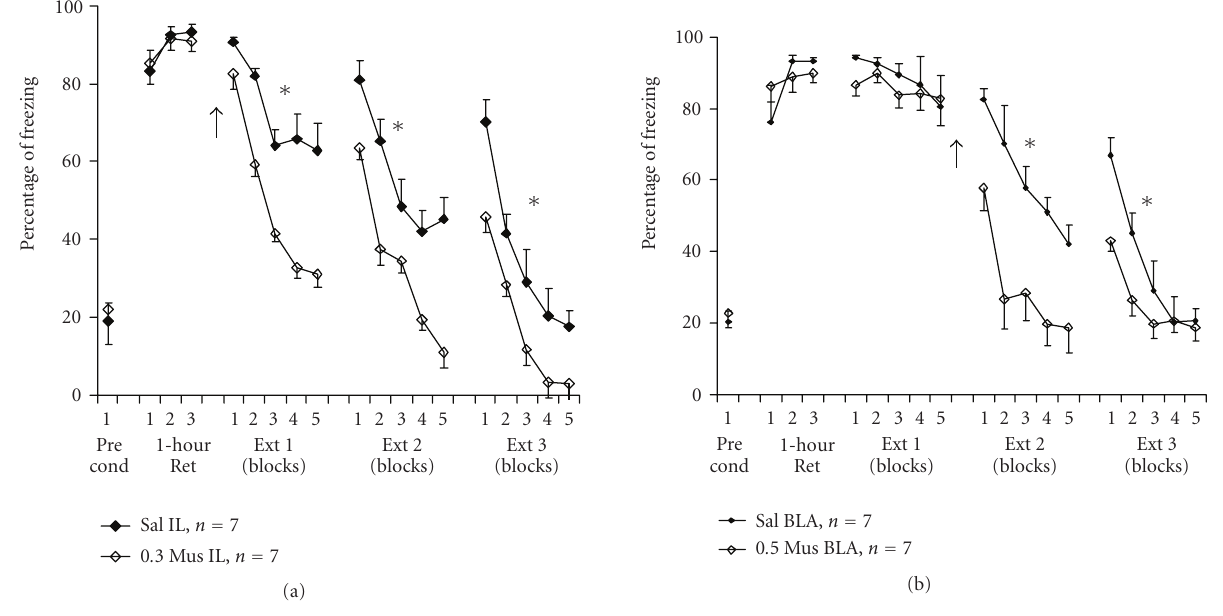
Figure 2: (a) A low volume of muscimol microinfused into the infralimbic cortex before extinction training facilitates extinction learning. Rats received 7 pairings of a tone with a foot shock in the conditioning chamber. After 1 hour, three tones were delivered in the absence of foot shock (1-hour Ret). On the next day, the animals were microinfused with a total of 0.3 μ l saline (Sal) or muscimol (0.3Mus) to the infralimbic cortex (IL) and were exposed to 15 tones without foot shocks (Ext 1; presented as 5 blocks of 3 trials). Animals were exposed to additional 15 tones on days 4 (Ext 2) and 5 (Ext 3), without further administration of the drug. Muscimol IL animals showed significantly lower levels of freezing compared with the saline group in Ext 1 ( ∗ ; P < . 001), Ext 2 ( ∗ ; P < . 01) and Ext 3 ( ∗ ; P < . 05). This supports a selective involvement of the IL in facilitating extinction of conditioned fear (see Akirav et al. [51]). Arrow denotes time of drug infusion. The Pre cond data points indicate the amount of freezing exhibited by rats prior to commencement of fear conditioning. (b) A low volume of muscimol microinfused to the basolateral amygdala following a short extinction training session facilitates extinction consolidation. Rats received 7 pairings of a tone with a foot shock in the conditioning chamber. After 1 hour, three tones were delivered in the absence of foot shock (1-hour Ret). On the next day, the animals underwent a short extinction training session consisting of 5 tones (Ext 1; presented as 5 trials), and were thereafter microinfused with a total volume of 0.5 μ l saline (Sal) or muscimol (0.5Mus) to the basolateral amygdala (BLA). On days 4 and 5 (Ext 2 and Ext 3, resp.), the animals were exposed to 15 tones without foot shocks (presented as 5 blocks of 3 trials). The BLA muscimol group showed significantly reduced levels of freezing compared with the other two groups during Ext 2 ( ∗ ; P < . 001) and Ext 3 ( ∗ ; P < . 05). This supports the selective involvement of the BLA in facilitating consolidation of extinction of conditioned fear (see Akirav et al. [51]). Arrow denotes time of drug infusion. The Pre cond data points indicate the amount of freezing exhibited by rats prior to commencement of fear